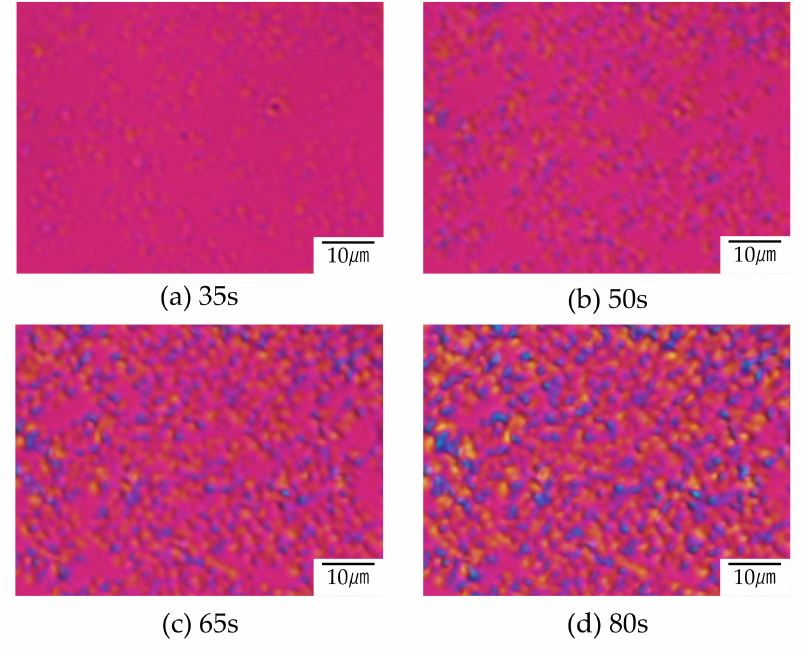
Figure 9. Structure development of 60 / 40 PTT / PET during the crystallization at 210 ◦ C after ( a ) 35 s,